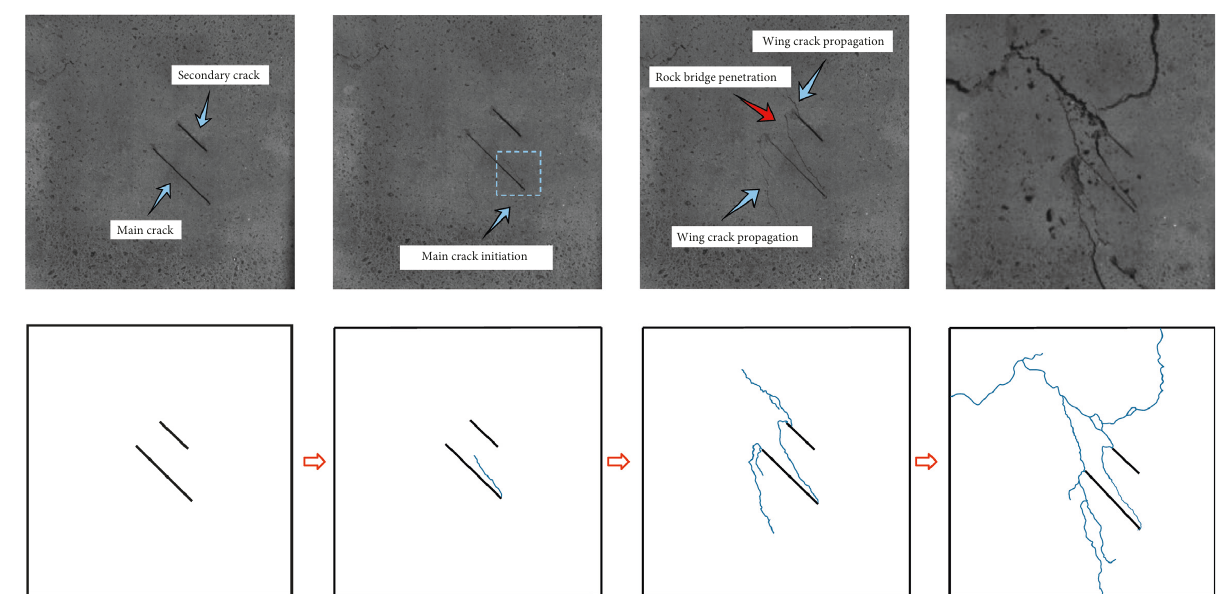
Figure 15: Crack propagation process of Specimen